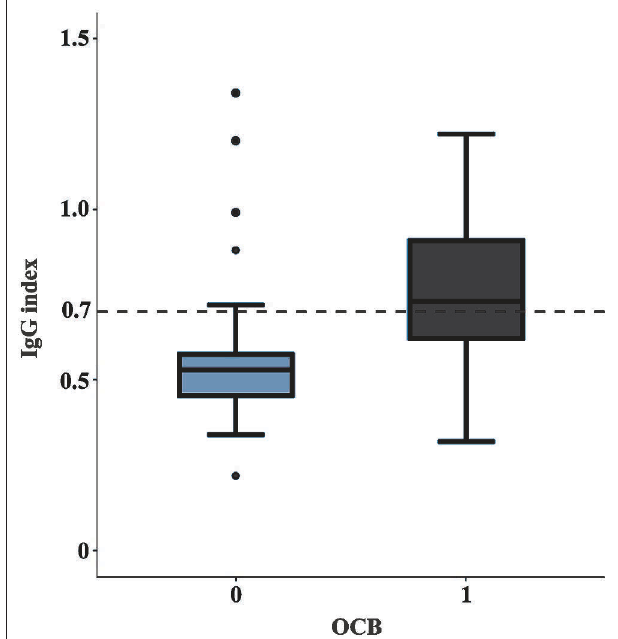
FIGURE 1 | Correlation between OCB positivity and IgG index. In box-and-whisker plots the central horizontal bar shows the median IgG index, and the lower and upper boundaries show the 25th and 75th percentiles, respectively. The dashed horizontal line represents an IgG index of 0.7. IgG index positivity (IgG index > 0.7, the cut-off in our center and also the often-used cut-off in many other centers) was highly associated with the OCB status (Chi-square test, X 2 = 22.90, P < 0.001). IgG, Immunoglobulin G; OCB, oligoclonal